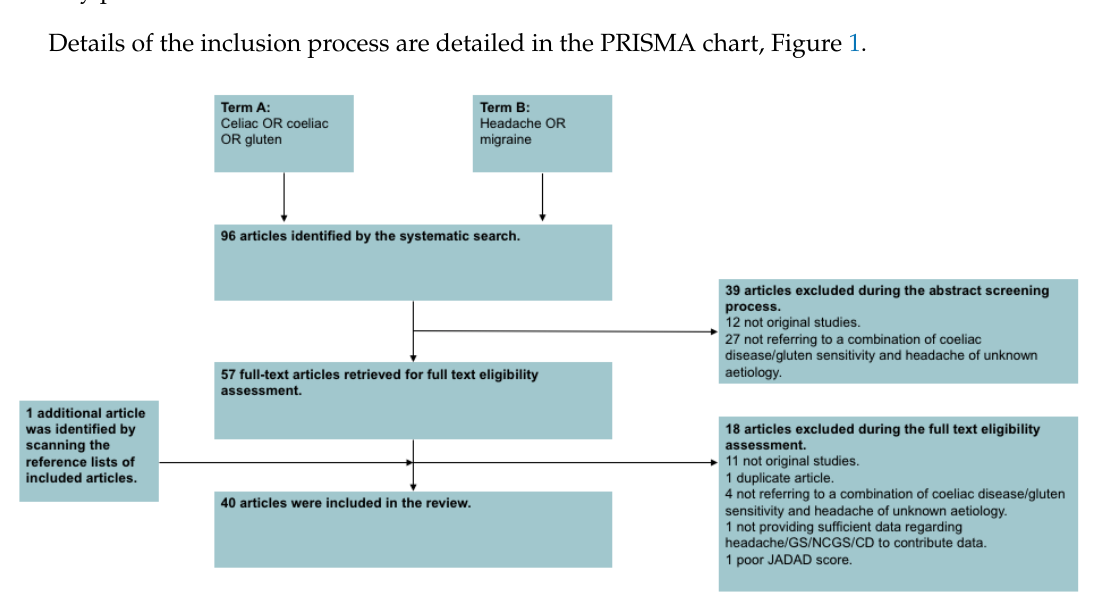
Figure 1. Preferred Reporting Items for Systematic Reviews and Meta-Analysis (PRISMA) chart.